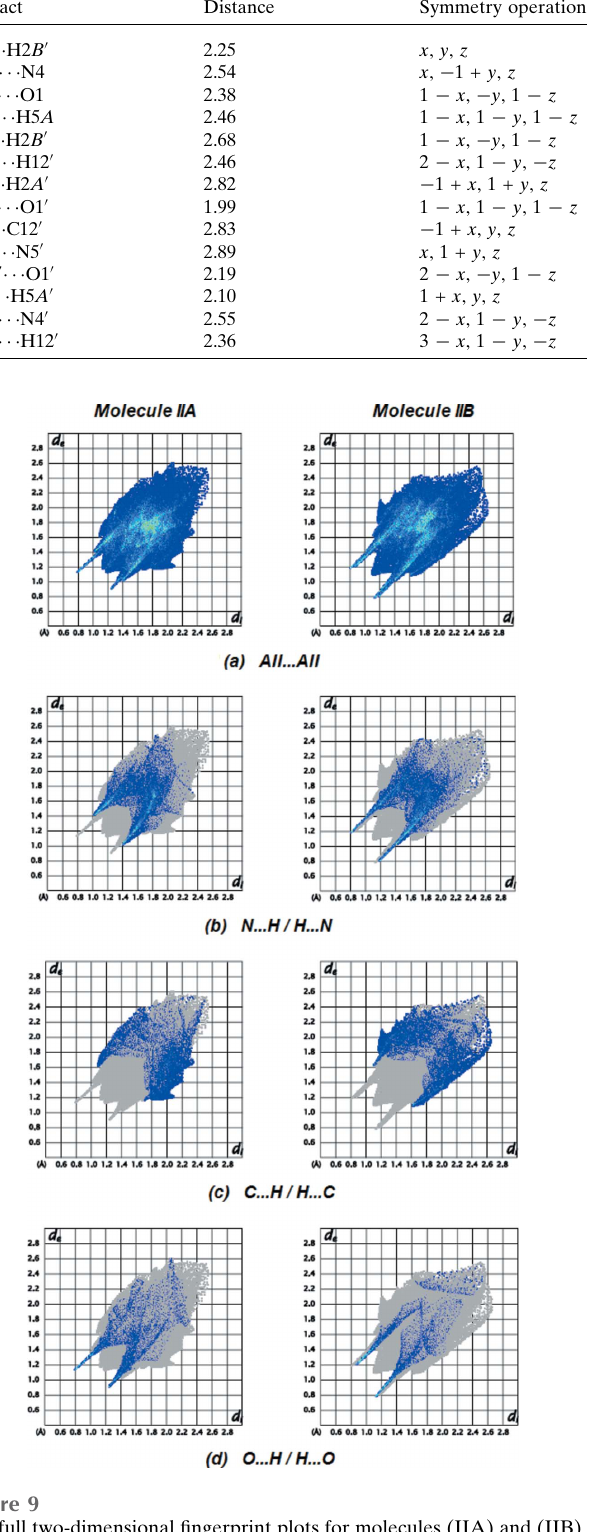
Table 5 Percentage contributions of interatomic contacts to the Hirshfeld surface for compound